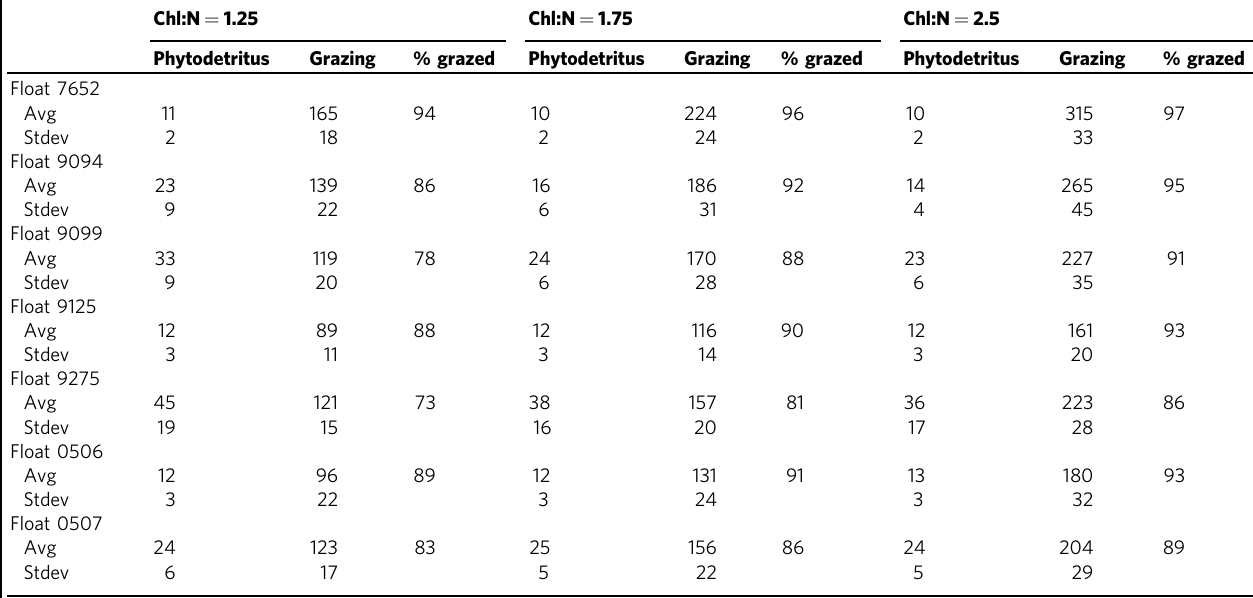
Table 1 Results of the sensitivity analysis of the method to the chl:N ratio ( µ g chl: µ mol N). Chl:N = 1.25